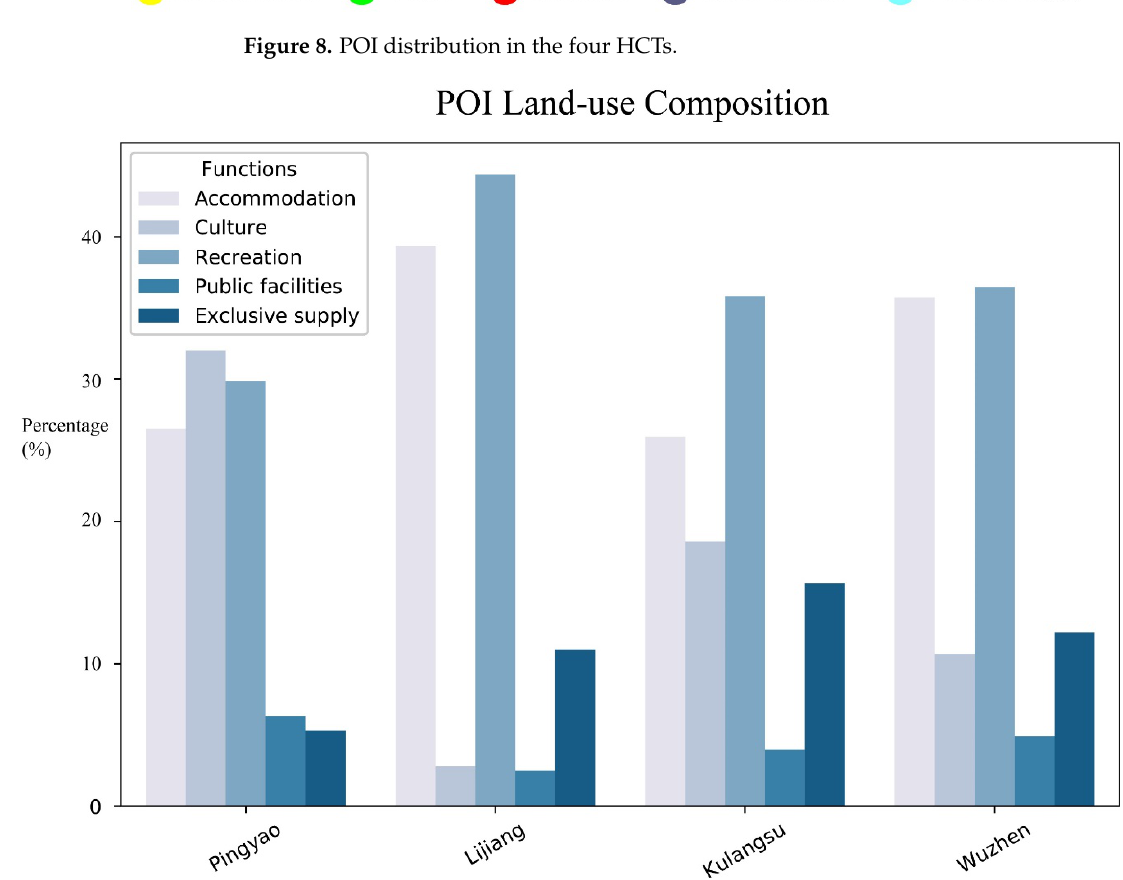
Figure 9. The ratio of the five types of POI land use in the four